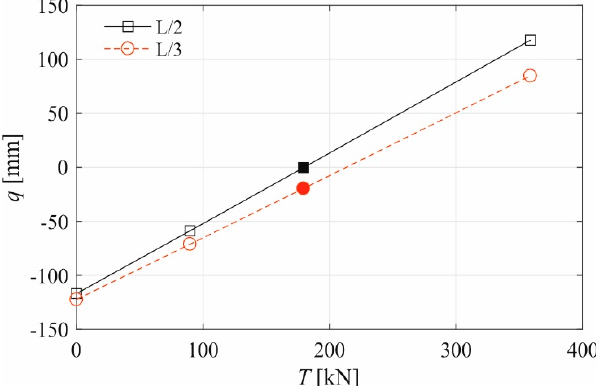
Figure 11. Vertical deflections at x = L /2 and x = L /3 for different values of cable prestress (filled markers identify the selected value of prestress).